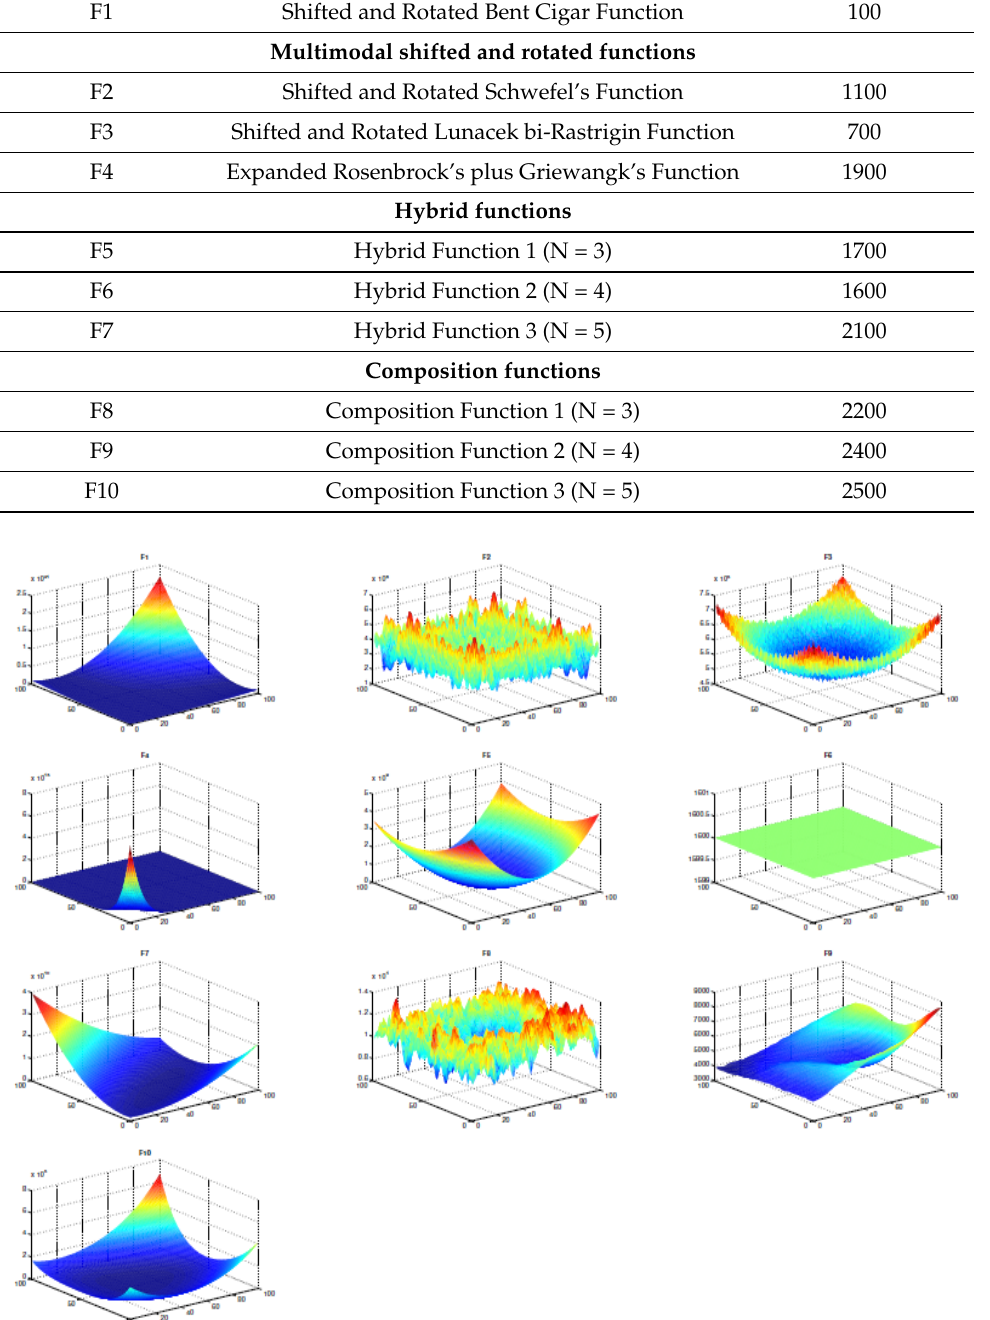
Figure 3. CEC’2020 benchmark functions in two-dimensional